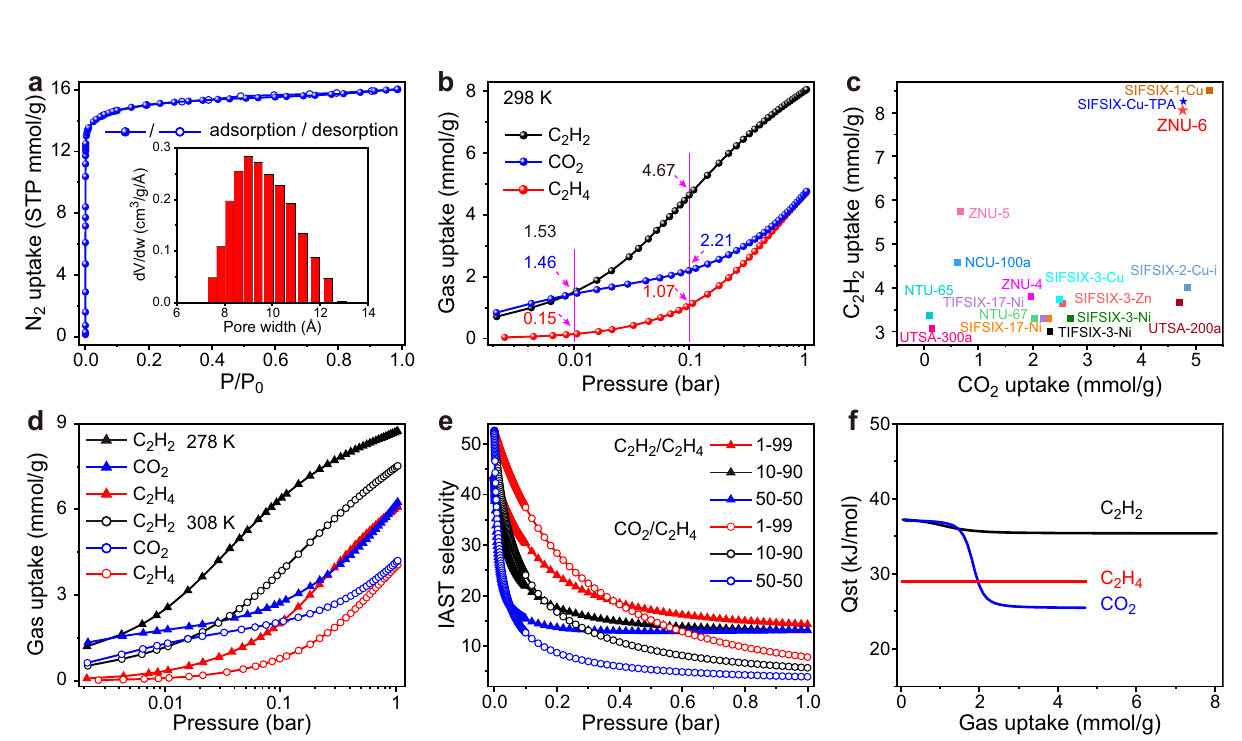
Fig. 2 | The sorption performance. a N 2 adsorption and desorption isotherms for ZNU-6and thecalculated poresizedistribution. b C 2 H 2 , CO 2 , and C 2 H 4 adsorption isotherms of ZNU-6 at 298K. c Comparison of the saturated C 2 H 2 and CO 2 uptake (1bar, 298K) among anion pillared MOFs. d C 2 H 2 , CO 2 , and C 2 H 4 adsorption